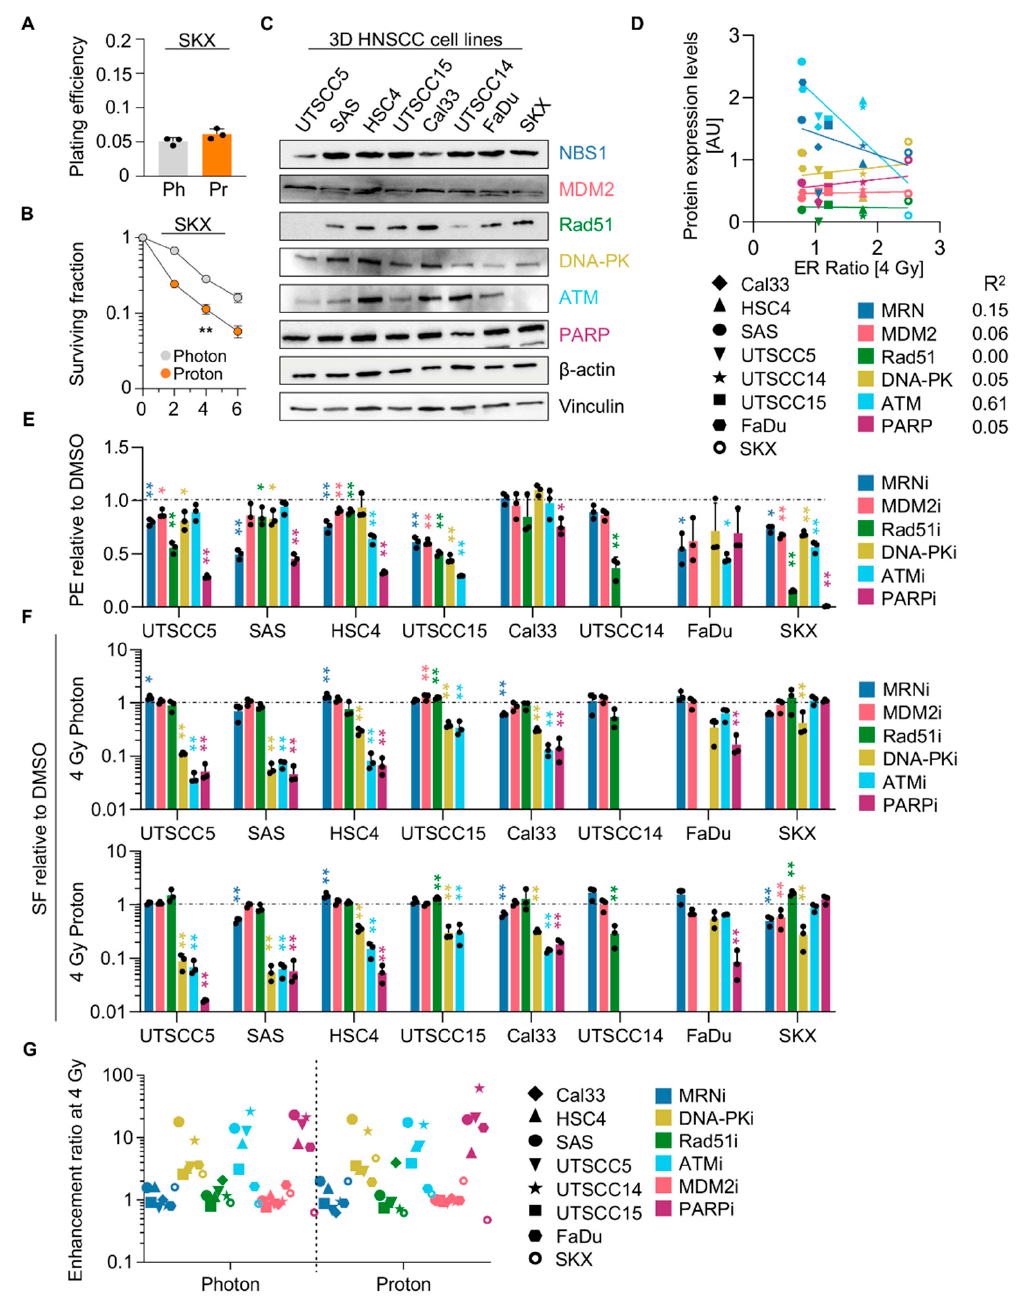
Figure 5. Specific DNA repair inhibitors mediate radiosensitization without discrimination between photon and proton irradiation. Plating efficiency ( A ) and clonogenic radiation survival ( B ) of 3D SKX cell cultures upon 2, 4, 6 Gy photon or proton irradiation. ( C ) Western blot analysis of indicated DNA repair proteins in indicated 3D HNSCC cell cultures. β -actin and Vinculin served as loading controls. ( D ) Correlation between enhancement ratios (ER; calculated by dividing the surviving fraction at 4-Gy proton irradiation by the surviving fraction at 4-Gy photon irradiation) and protein expression levels (see Table S1). ( E ) Normalized plating efficiencies of 3D HNSCC cell cultures upon pretreatment with indicated DNA repair inhibitors (all at 10 µ M). DMSO served as control. ( F ) Normalized clonogenic survival of 3D HNSCC cell cultures upon 4-Gy photon or proton irradiation in presence of DNA repair inhibitors (all at 10 µ M) relative to DMSO controls. ( G ) Enhancement ratios for combined inhibitor/4-Gy irradiation. All results show mean ± SD ( n = 3, two-sided t -test, * p < 0.05, ** p < 0.01). Ph, photon irradiation; Pr, proton irradiation; PE, Plating efficiency; SF, Surviving